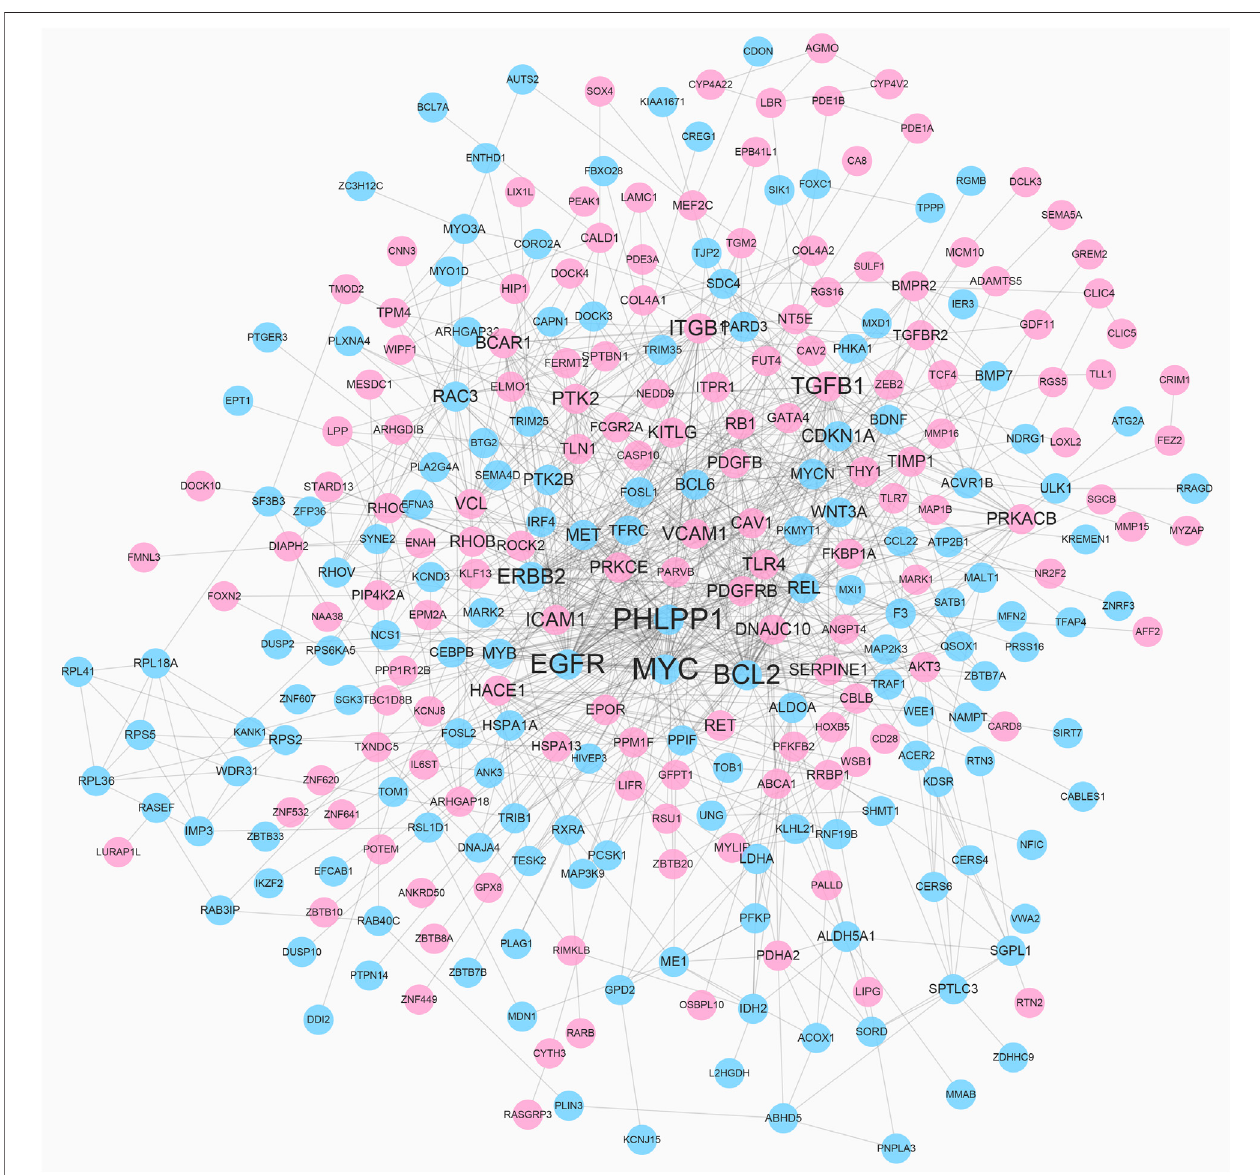
FIGURE 5 | PPI network of DEGs. Red nodes represent up-regulated DEGs and blue nodes represent down-regulated DEGs. Nodes with higher degree are depicted with larger label size.